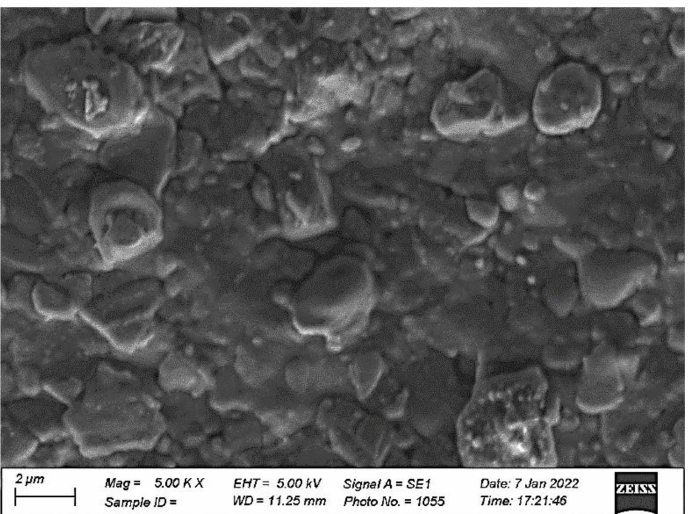
Figure 2. The SEM image showing the surface morphology of the orange dye film. The surface roughness and porosity are more pronounced in the micrograph.